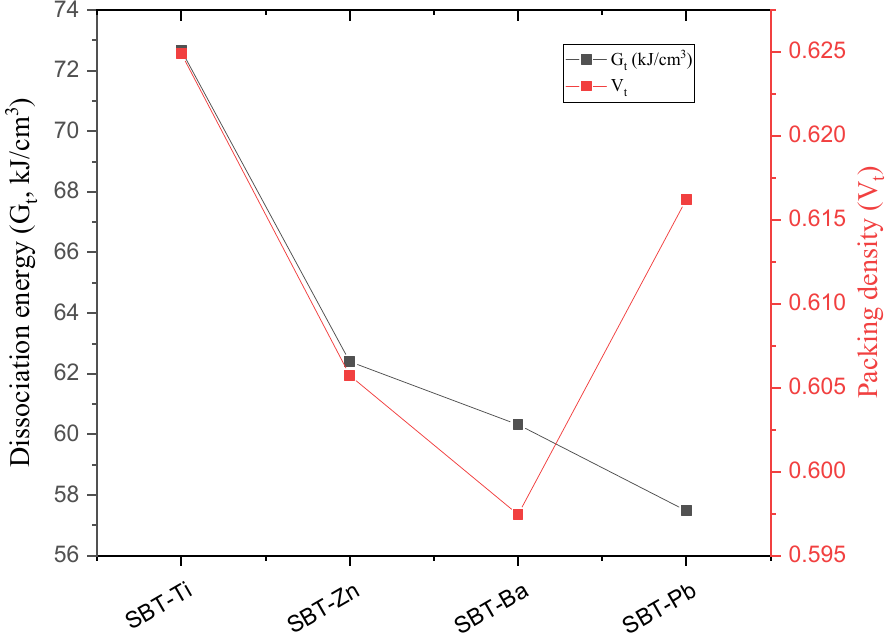
Figure 3. The relationship among the dissociation energy ( G t ) and packing density ( V t ) of the fabricated SBT glasses.